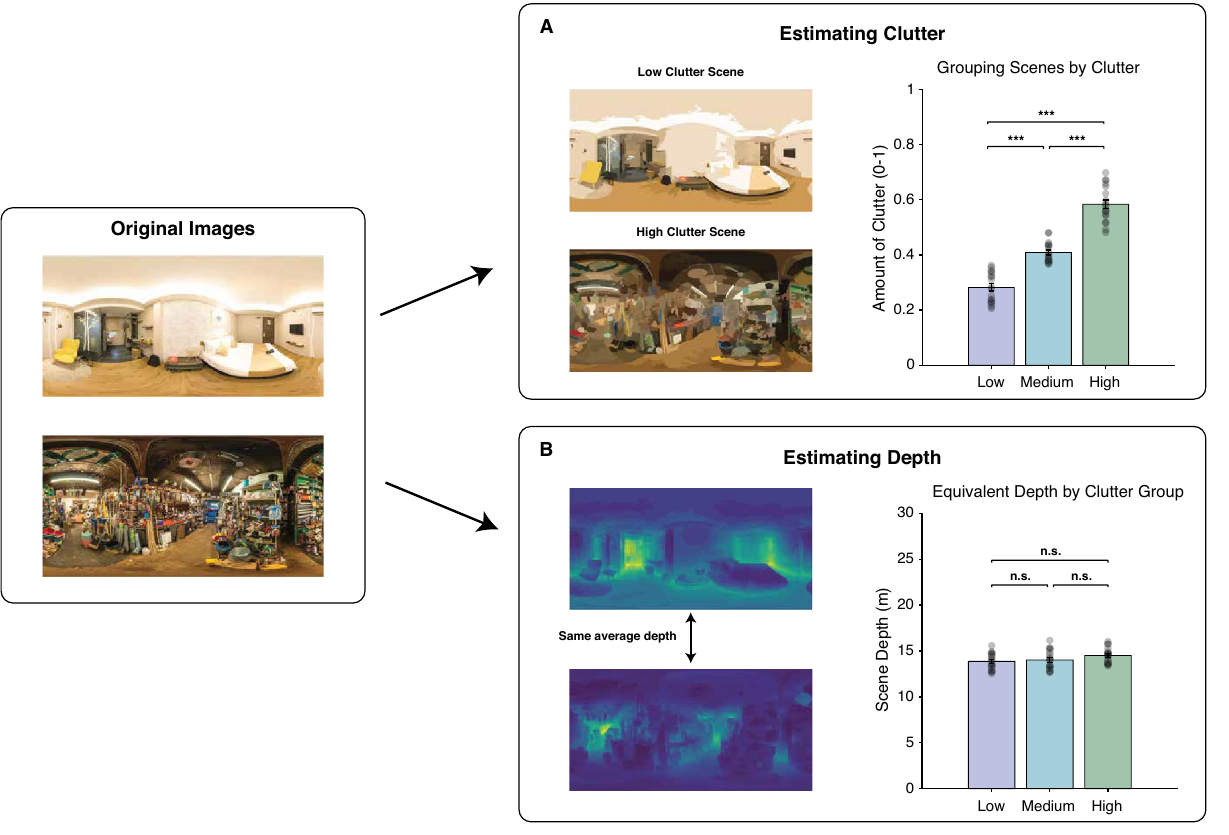
Figure 1. Visual clutter and depth estimation in real-world scene stimuli. ( A ) Example visualizations of visual clutter estimated by the proto-object segmentation algorithm. Photospheres were divided into three bins, and average clutter of each bin significantly differed from the others ( F (2,51) = 144.7, p < 0.001). ( B ) Example visualizations of scene depth estimated by the big-to-small algorithm. The average depth of each clutter bin did not significantly differ ( F (2,51) = 1.20, p = 0.331). In all plots, error bars represent 1 SEM. * p < 0.05, ** p < 0.01, *** p < 0.001, n.s. p >